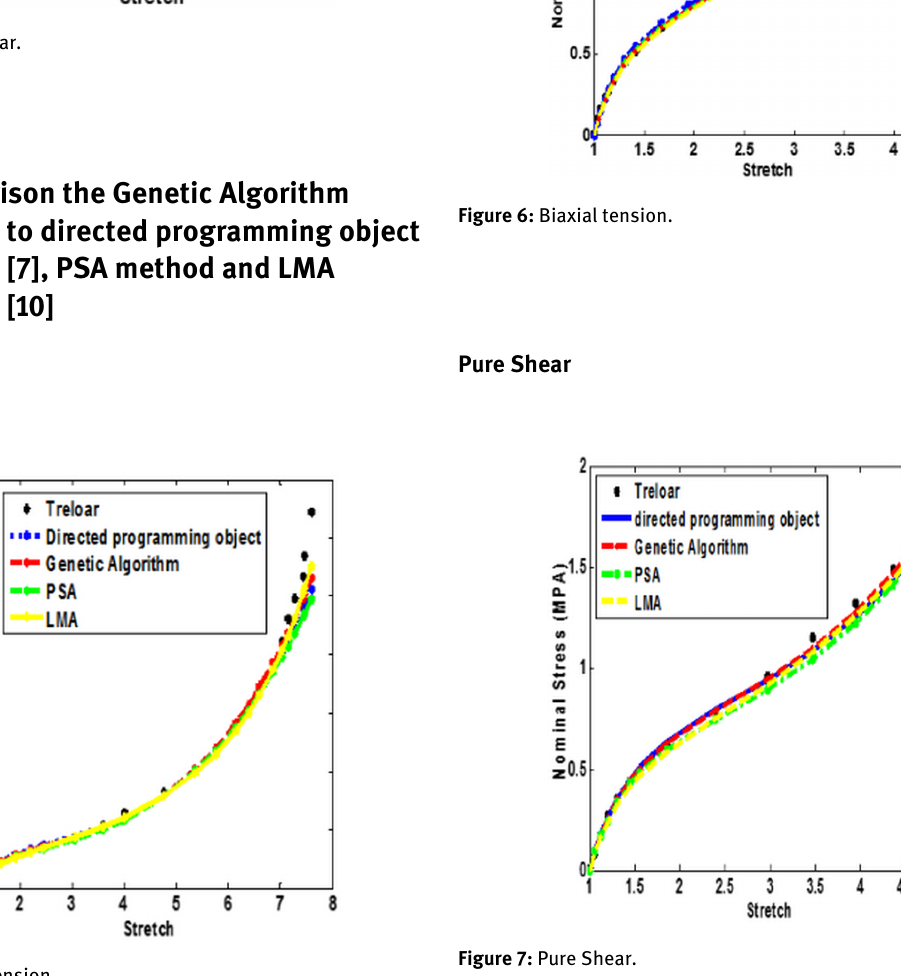
Figure 5: Simple tension.